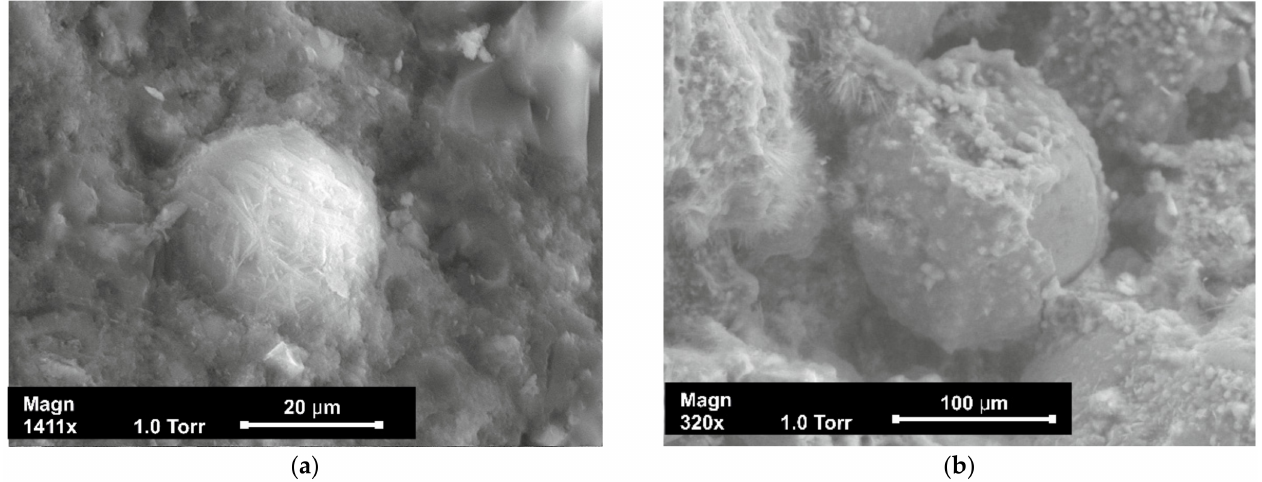
Figure 6. SEM microscope images of samples contain 2.6% FAM with grain diameter: ( a ) <200 µ m; ( b ) and <500 µ